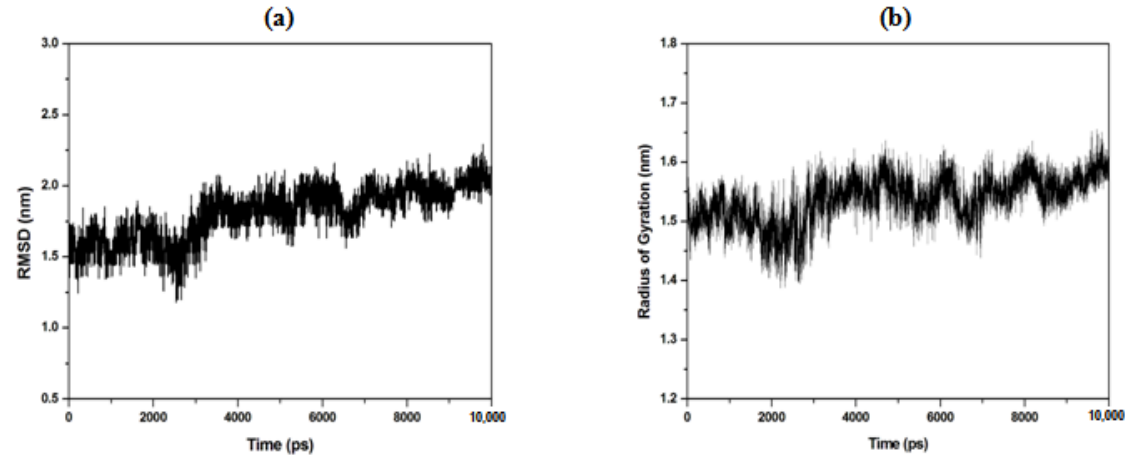
Figure 5. Molecular dynamics of ( a ) RMSD of amylose solvated in SPC water molecules at 298 K for 10 ns. The trajectory for analysis was taken from the last 2 ns of the NPT production simulation. ( b ) Average radius of gyration (RoG) of 50 molecules of amylose, representing the amylose region solvated in SPC water molecules at 298 K and 1.0 bar.